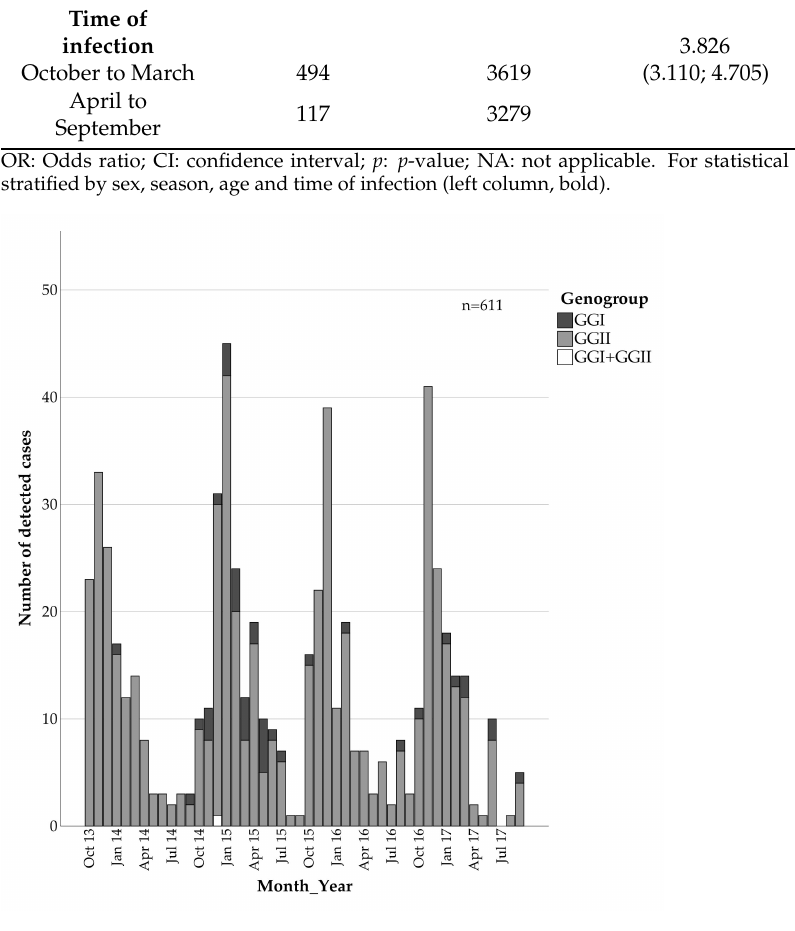
Figure 1. Monthly distribution of detected norovirus GGI and GGII strains, Leipzig University Hospital, October 2013–September